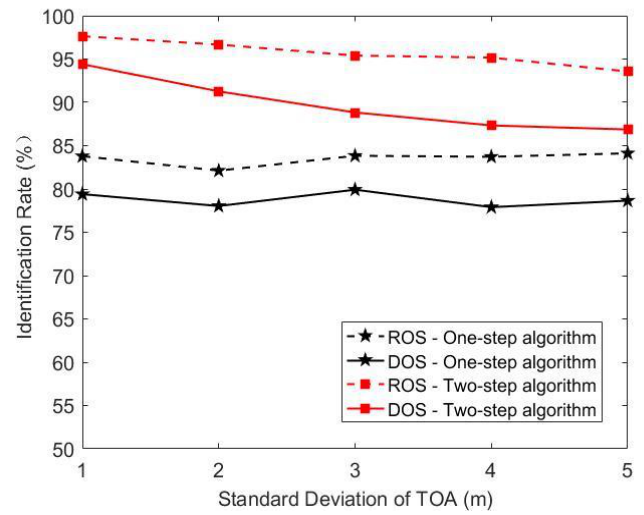
Figure 6. 𝑃 𝐼𝐸 versus 𝛿 𝑇 . Figure 6. P IE versus δ T